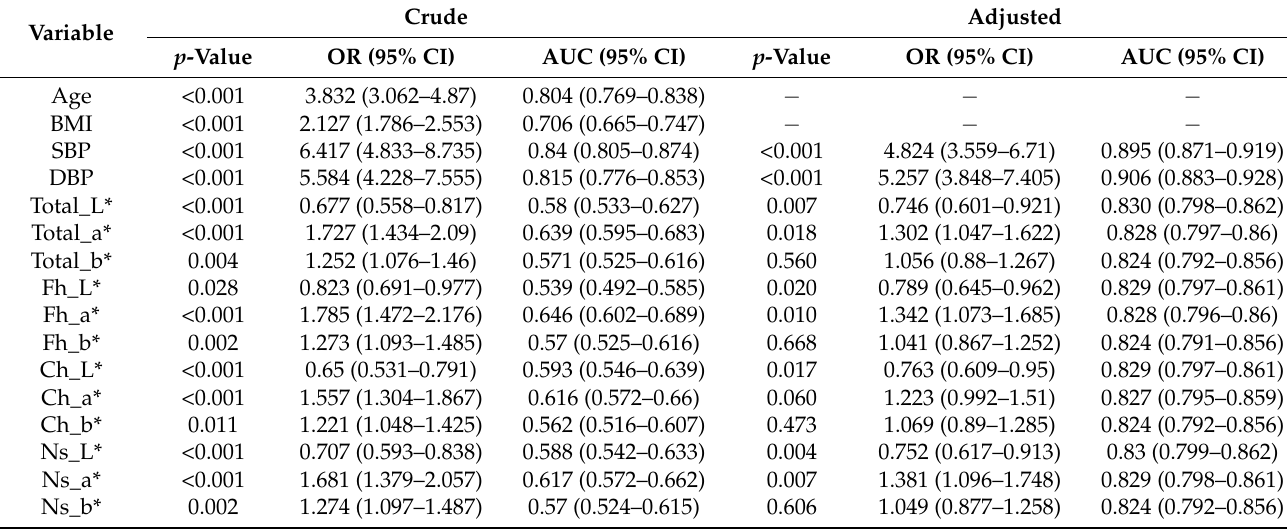
OR, Odds Ratio; AUC, area under the receiver operating characteristic curve; CI, confidence interval; ’ − ‘, not applicable; ’*’, indication for the Euclidean distance of two color stimuli specified in CIELAB. The statistical analysis of the data was performed using logistic regression with individual complexion variables as predictors after the data were transformed by standardization. The ORs and p -values in the adjusted parts of the table were adjusted by age and BMI. The values of AUC and confidence intervals of AUC using 5-fold cross-validation were calculated using the influence curve